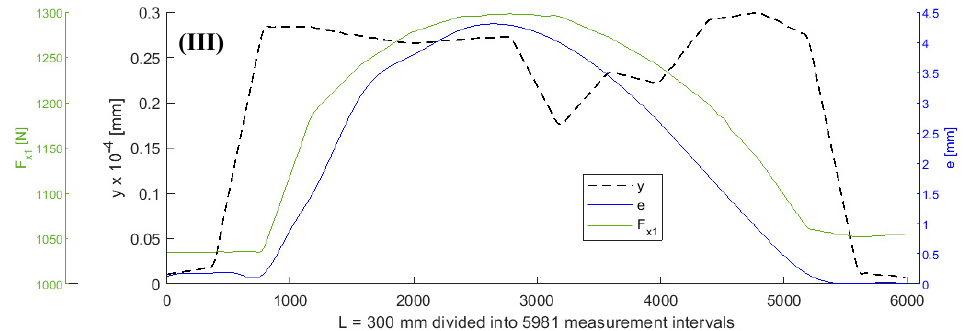
Figure 5. Curves of objective function y, tensile force Fx 1 , and eccentric e for d = 8 mm, F be =147 N, Fx 10 = 980 N, L = 300 mm, F f =196 N.